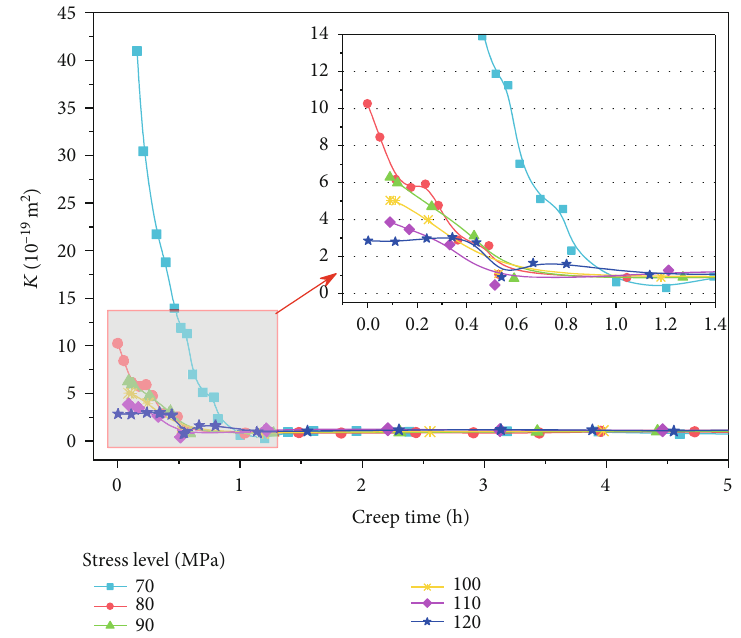
Figure 9: Permeability variation at di ff erent stress levels during the loading phase.